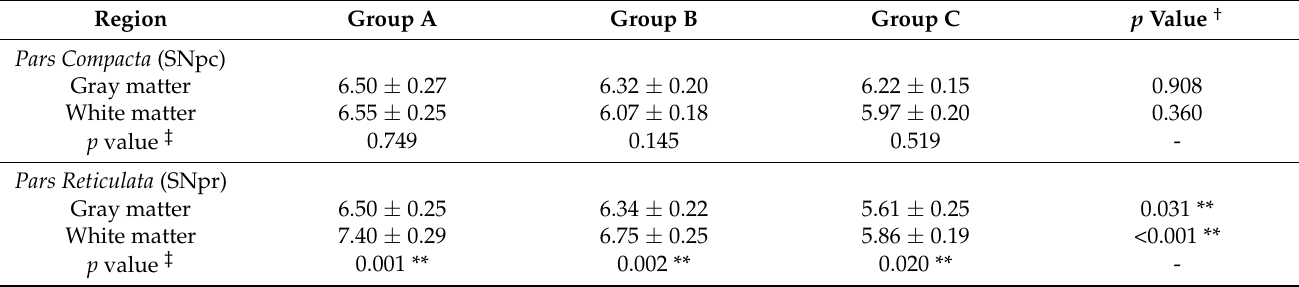
Table 4. Distribution of CD68+ cells per visual field in different regions of Substantia Nigra (SN). Region Group